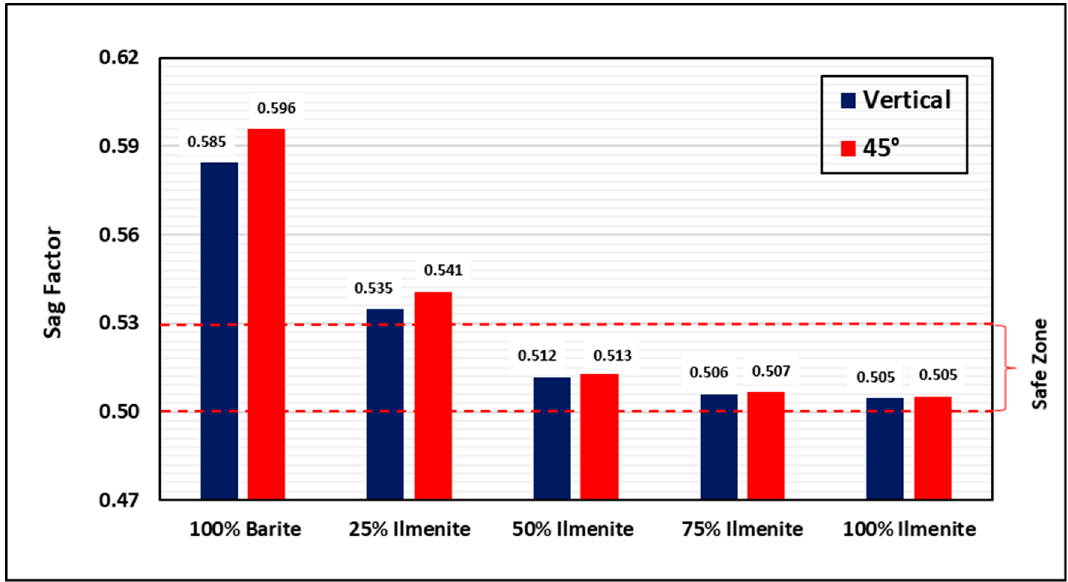
Figure 7. E ff ect of ilmenite on sag tendency under static conditions (250 ◦ Figure 7. Effect of ilmenite on sag tendency under static conditions (250 °F).